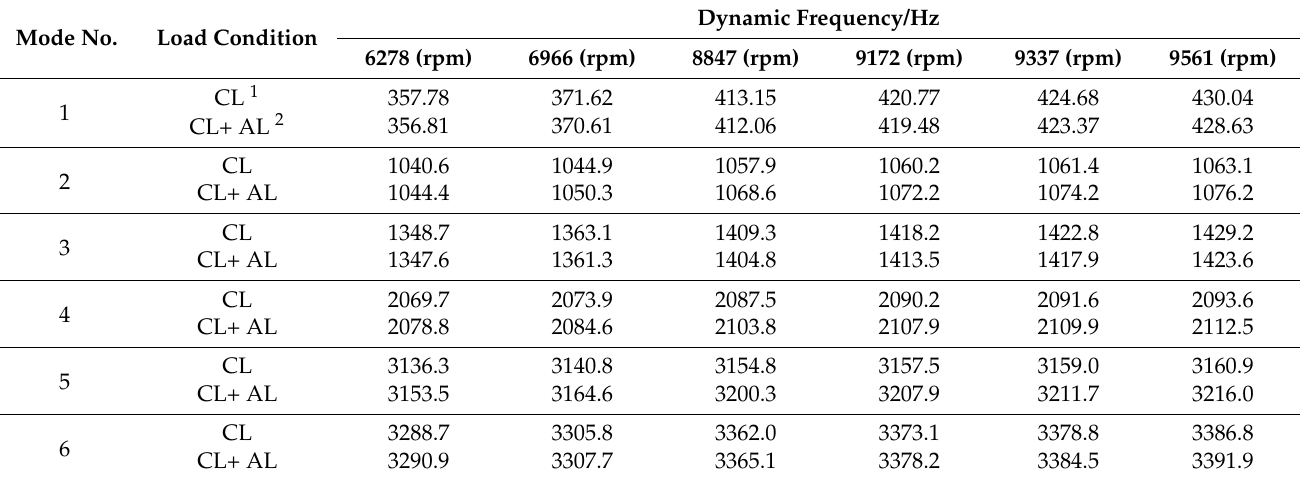
Table 3. The natural frequency of the blade in typical engine conditions